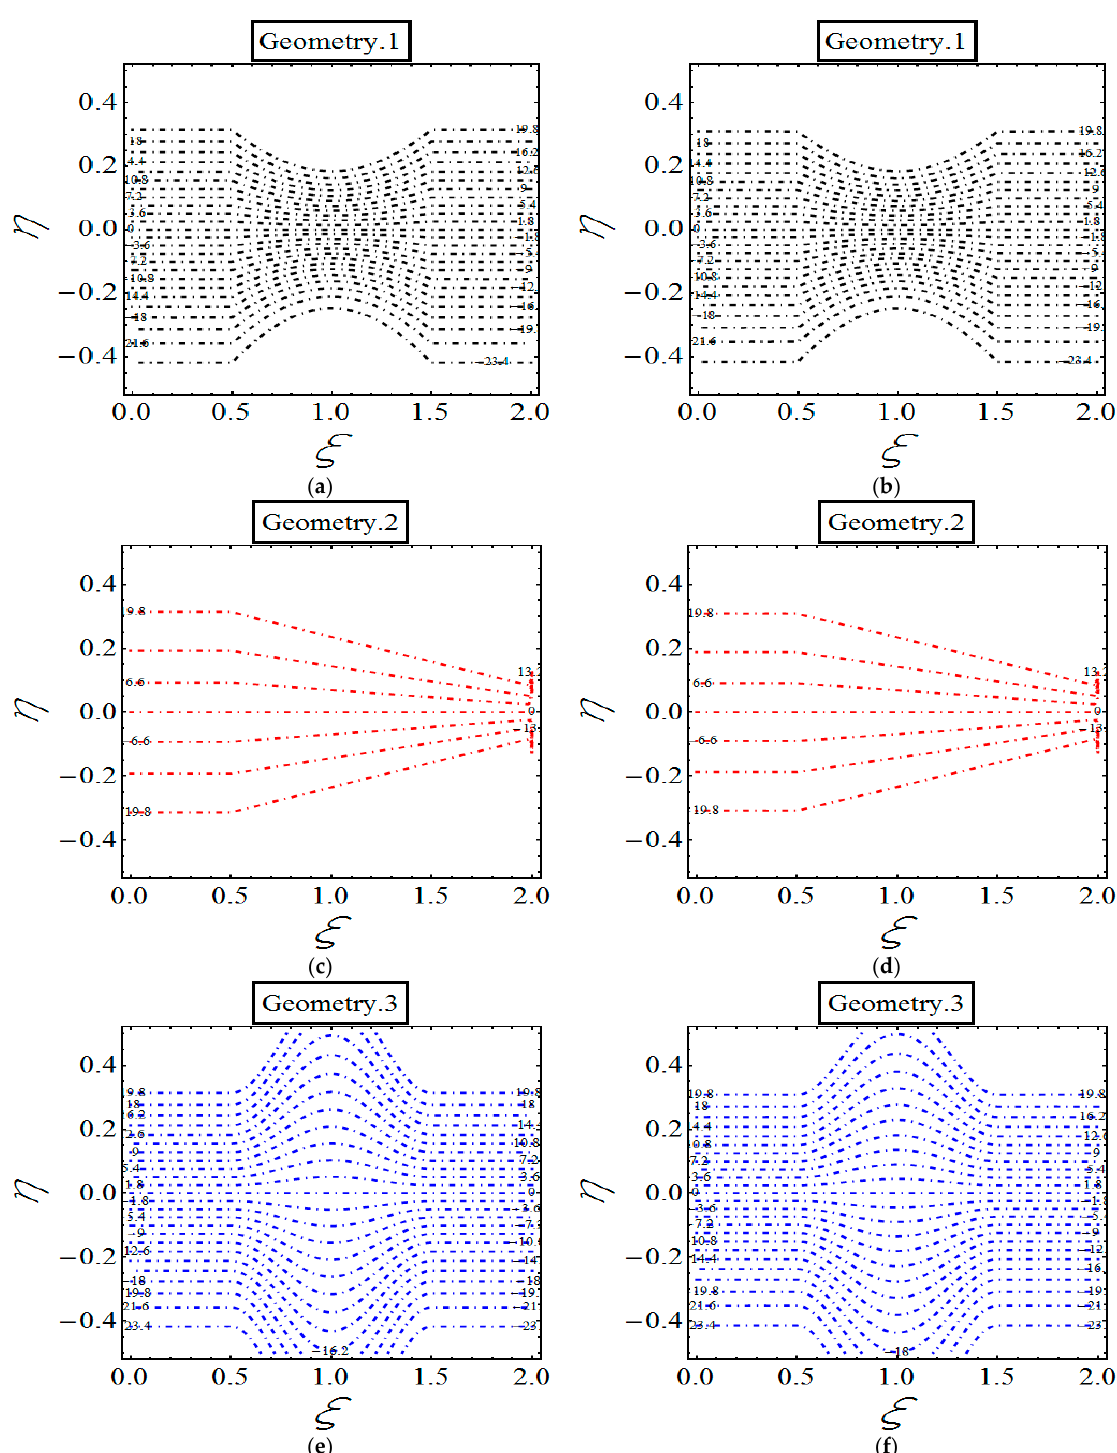
Figure 12. Stream lines for various Helmholtz–Smoluchowski velocities U HS = 2 ( a , c , e ) and U HS = 5 ( b , d , f ) in three geometries.